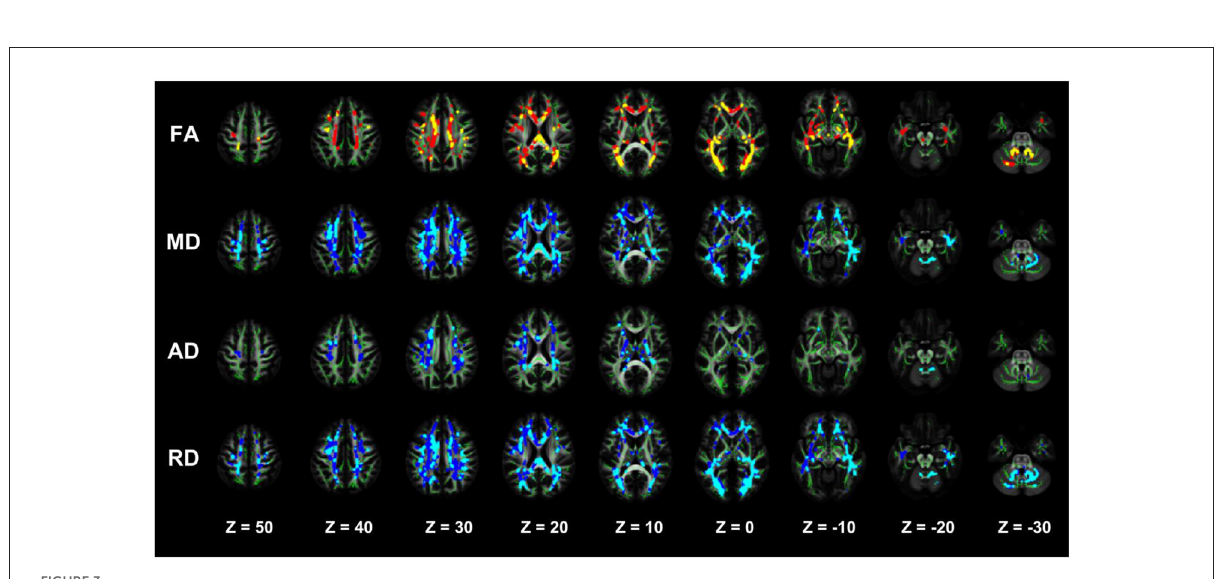
FIGURE3 TBSS analysis showing abnormal white matter bundles for DTI parameters, with the FA, MD, AD, and RD difference areas between the NDD-CKD and DD-CKD groups. Yellow or light blue color represents the commonly damaged area, corresponding to *in the table below; red or dark blue color represents the area damaged in the DD-CKD group and not damaged in the NDD-CKD group, corresponding to # in the table below. FA, fractional anisotropy; MD, mean diffusivity; AD, axial diffusivity; RD, radial diffusivity; TBSS, region-based spatial statistics; DTI, diffusion tensor